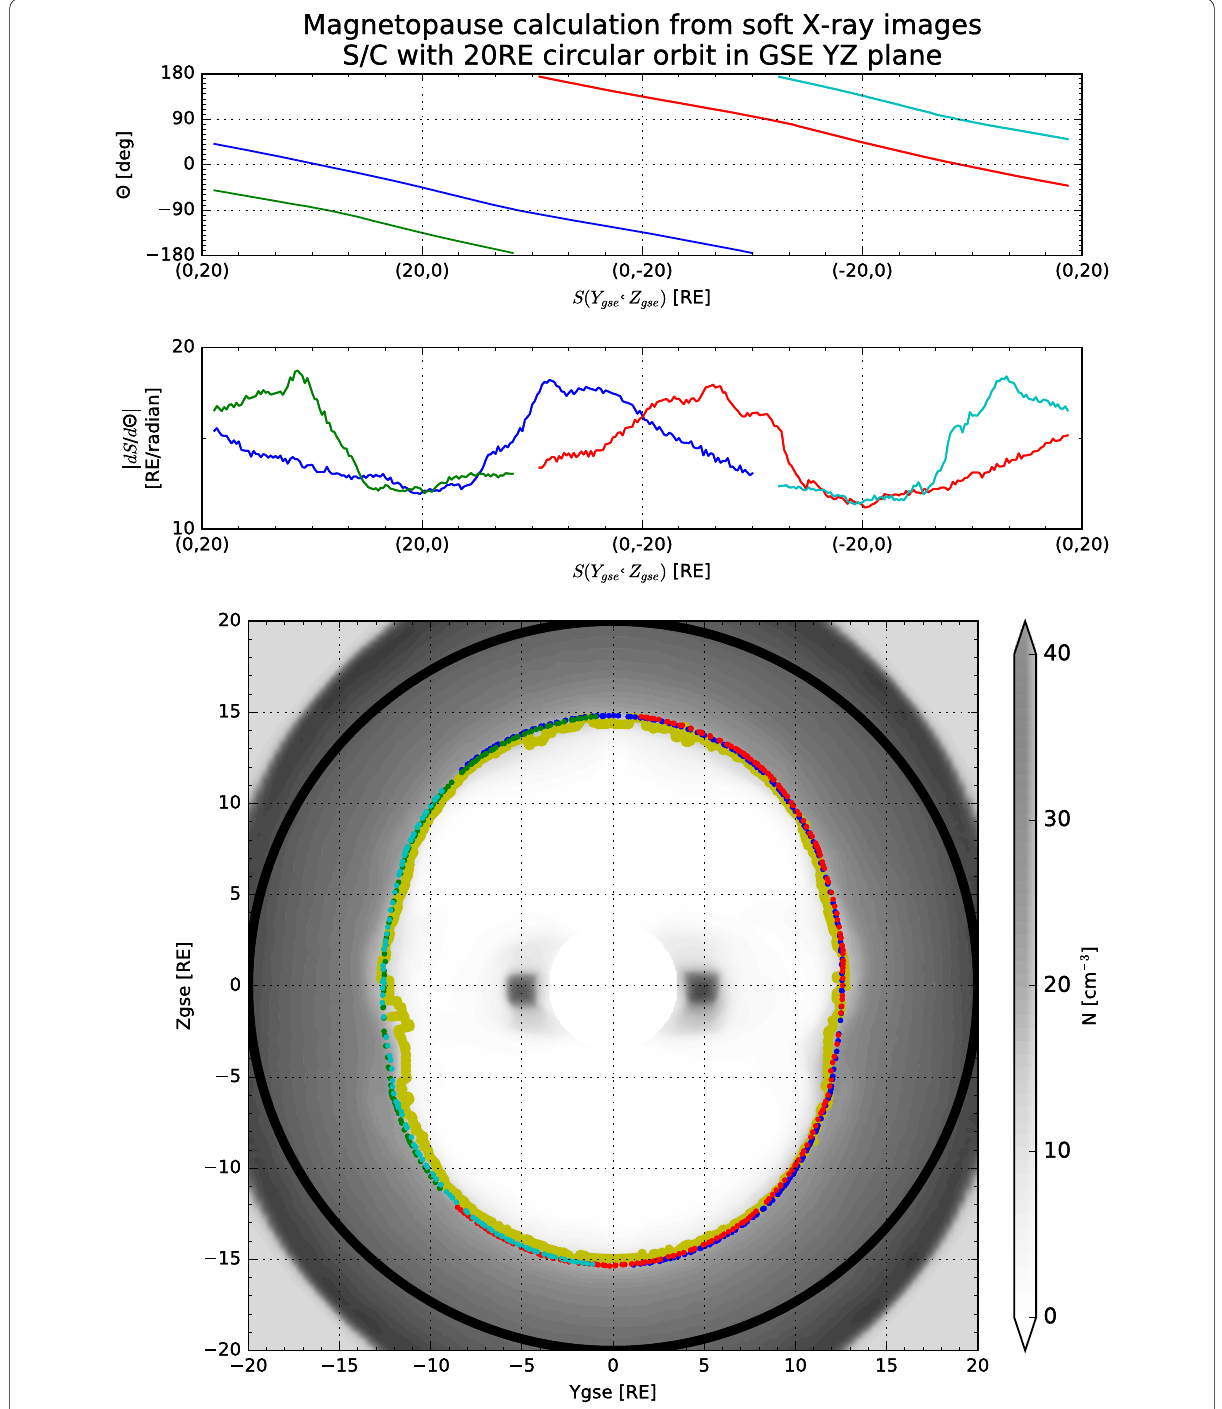
Fig. 4 Reconstruction of the magnetopause. Application of the magnetopause reconstruction algorithm for a circular orbit in the GSE XZ plane (Figure adapted from Collier and Connor